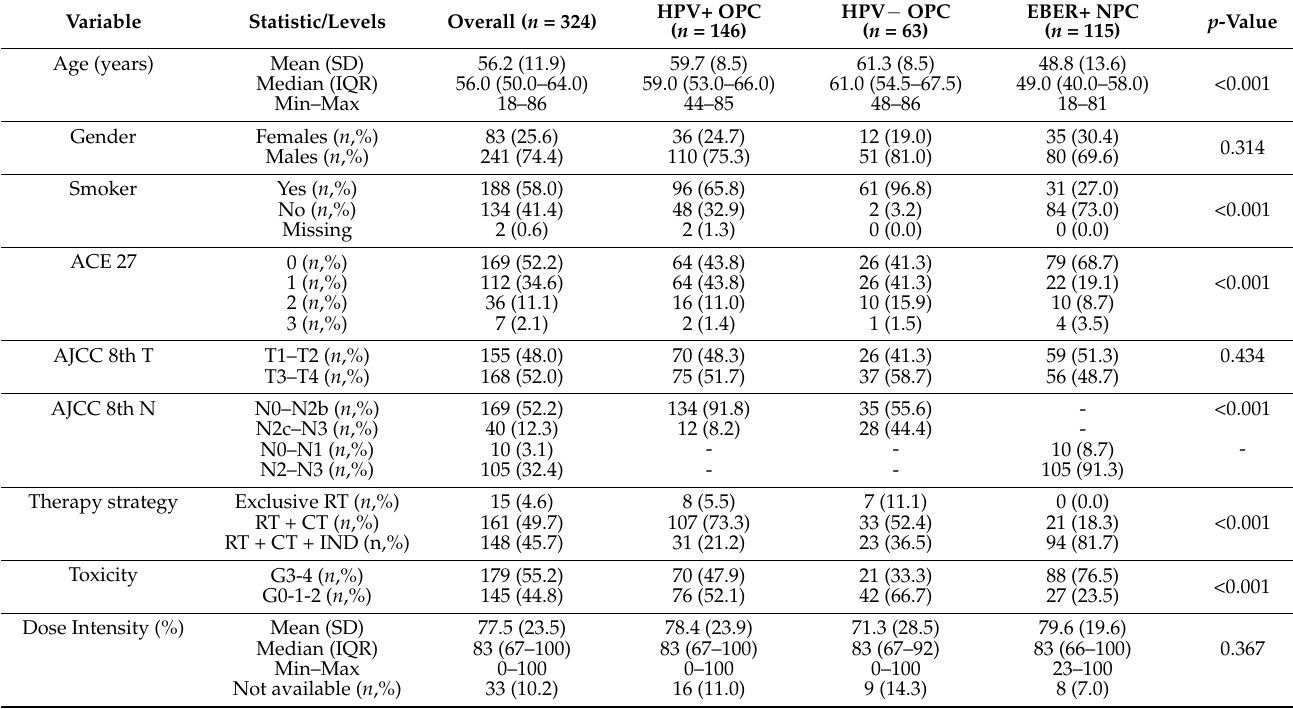
Table 1. Patient characteristics overall and according to study